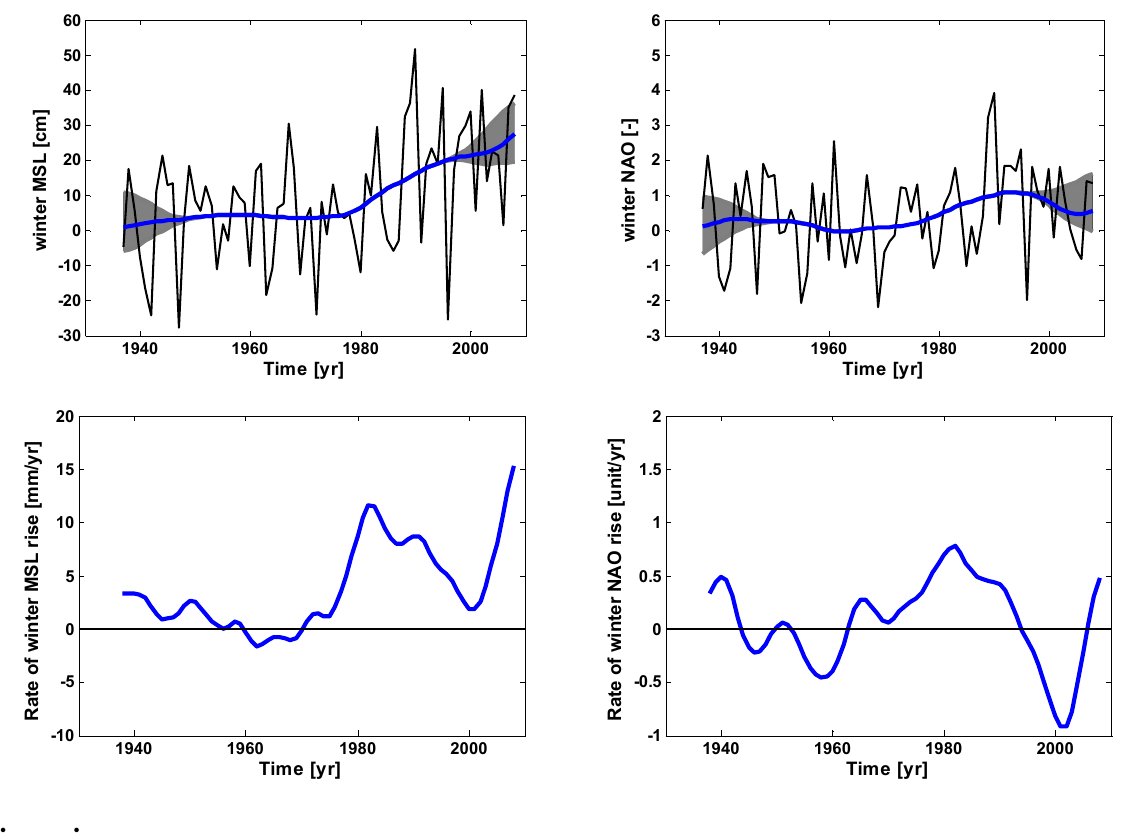
Figure 9. Time series of swMSL and swNAO for the German Bight (black lines, top) and LOWESS smoothing (blue lines, top). The grey-filled areas indicate the results of the MCAP method. The annual rates of rise calculated as the first differences of the smoothed time series are shown in the plots at the